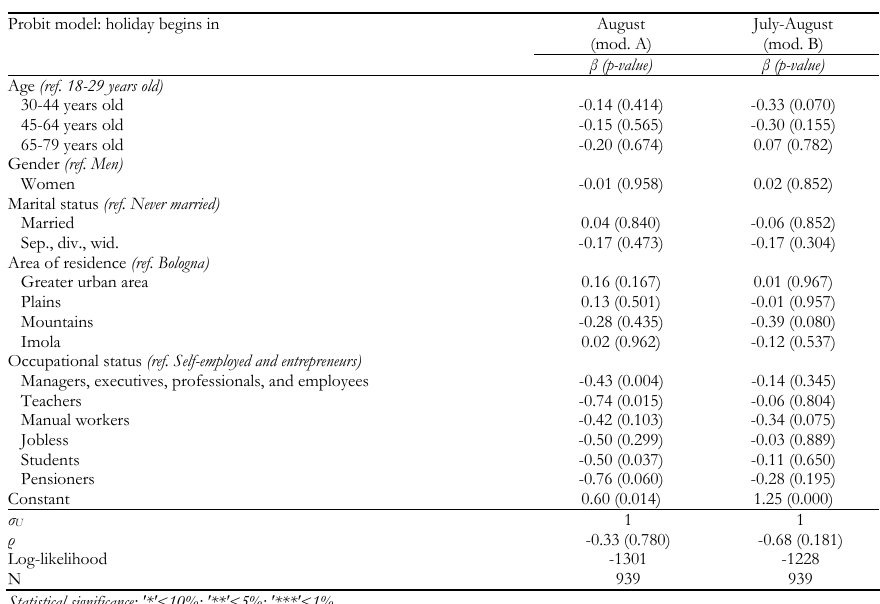
Heckman models: propensity to start the longest holiday during summer months (August or July-August) according to socio-demographic factors during